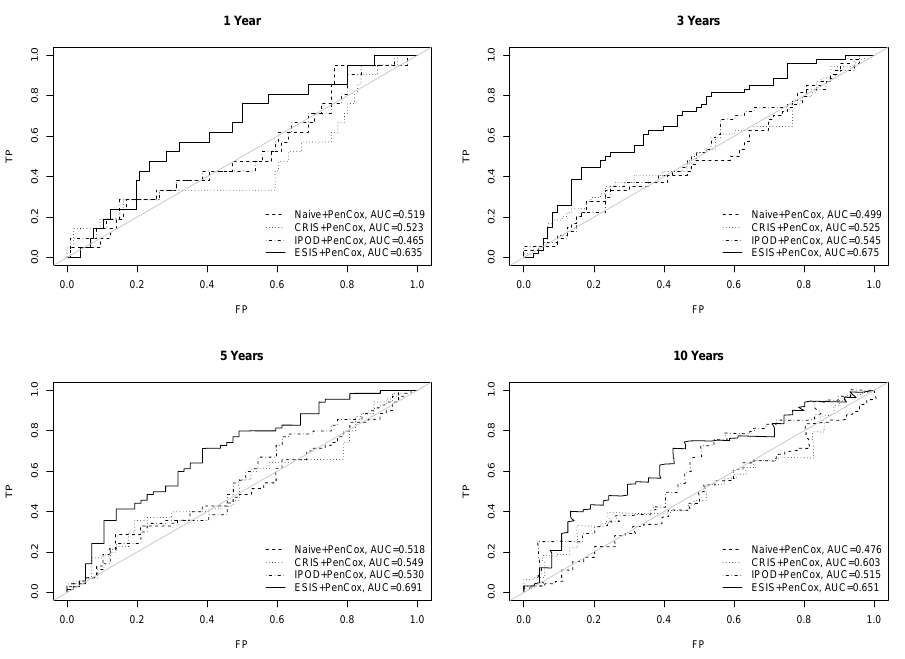
Figure 4. ROC curves of overall survival predicted by the four competing models on the external validation data.